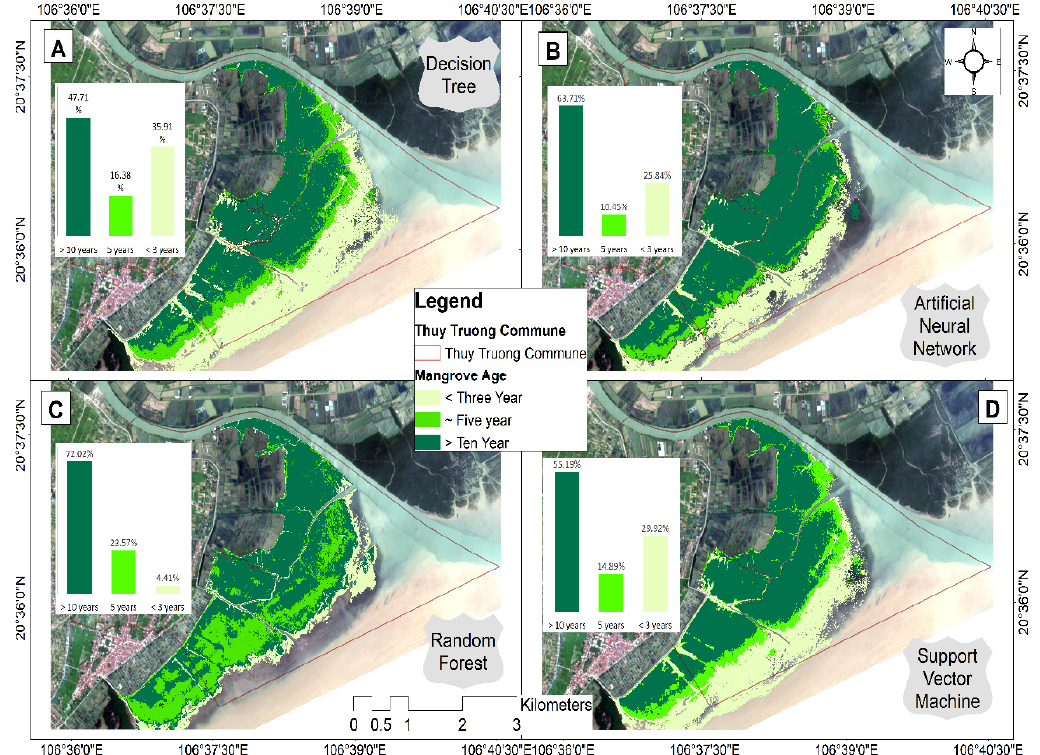
Figure 4. Maps of classifications using the multispectral data of SPOT-7 acquired on 17 May 2019 for mangroves of ages older than 10 years, around five years, and younger than three years, mapped for the four classifiers of decision tree ( A ), artificial neural network ( B ), random forest ( C ), and support vector machine ( D ). The background is the SPOT-7 true-color composition image and the red polygon shows the border of the Thuy Truong commune.